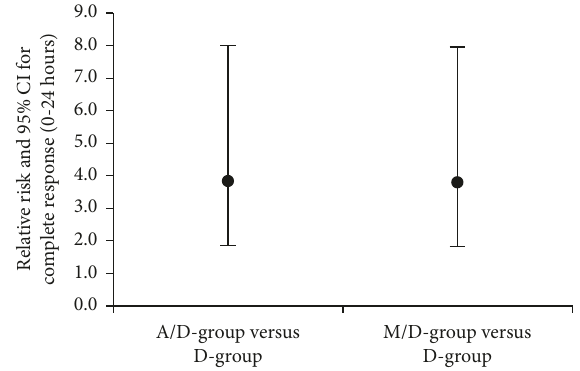
Figure 3: Relative risk with 95% CI for A/D group vs. M/D group for complete response in the first 24h after surgery; showing that the probability of complete response relative to the D group was in the M/D group close to that in the A/D group. A/D group: aprepitant/dexamethasone group, M/D group: mirtazapine/dexa- methasone group, and D group: dexamethasone 0 . 001) (Table 3). No patients needed any specific re- spiratory care in the postoperative period.